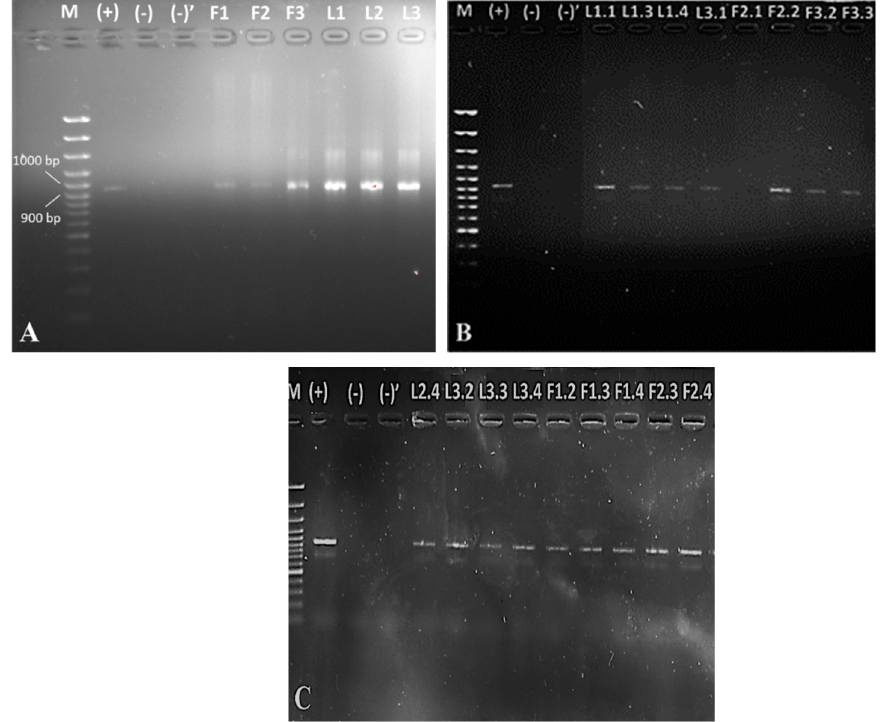
Figure 2. Detection of E. coli isolated from lagoons L1–L3 and faeces F1–F3 ( A ) and from single colonies ( B , C ) by 16S rDNA PCR. Legend: M, marker; (+), positive control ( E. coli O:157 for 16S rRNA PCR identification); ( − ), control of purity in the place of dispensing MasterMix; ( − )’, control of purity in the place of dispensing